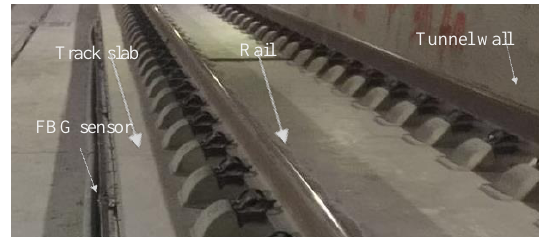
Figure 1. High-speed rail (HSR) slab track system in the tunnel.